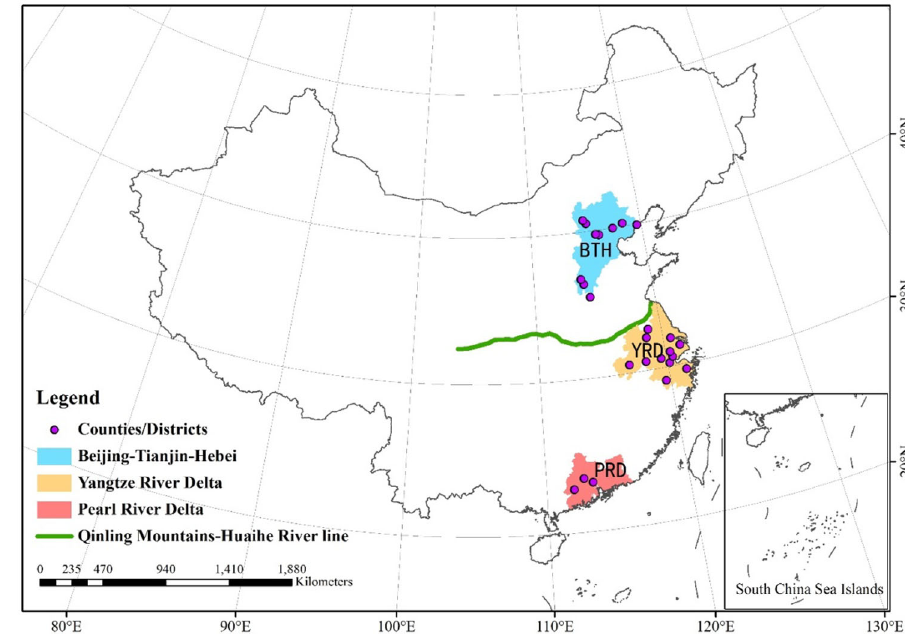
Fig. 1 Locations of the study’s three city clusters and the 25 county-level